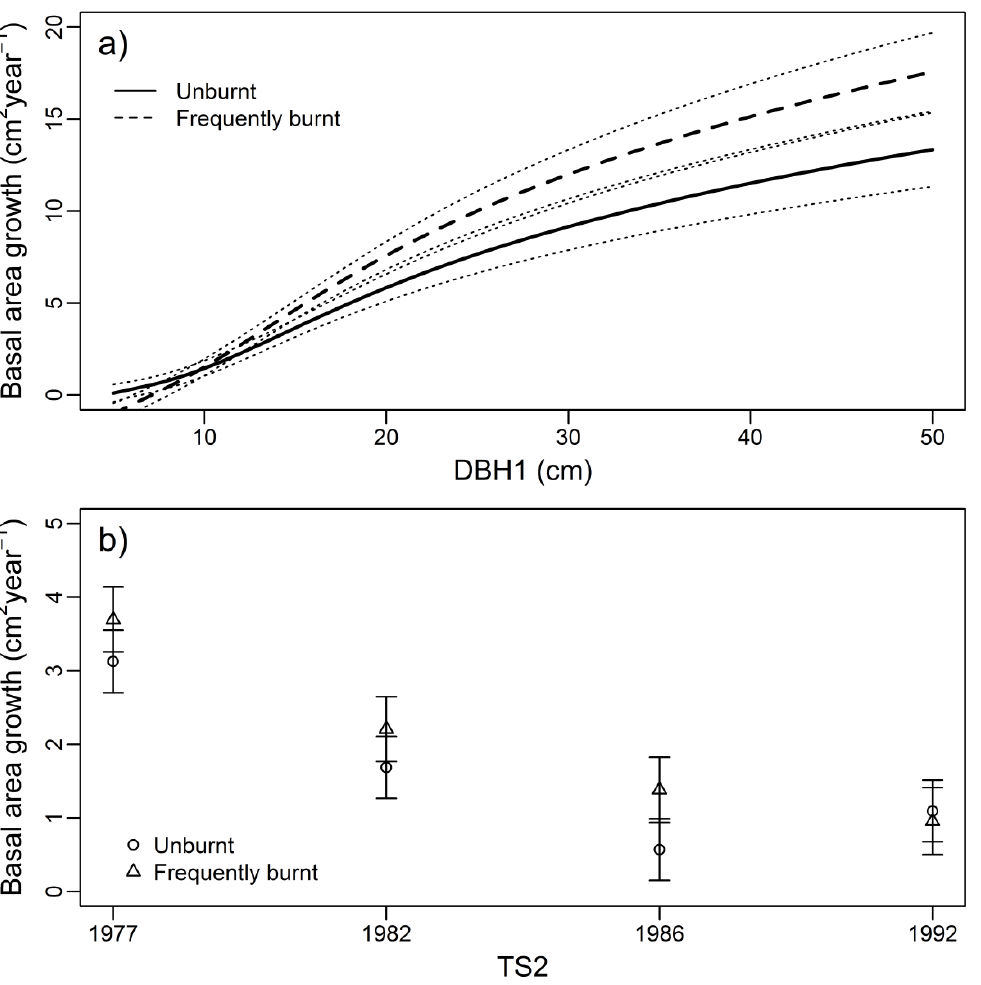
Figure 5. Model predictions of annual change in basal area of understorey species between measurement periods (cm 2 year −1 ) in response to: ( a ) burning treatment and DBH at the first survey (DBH1); and ( b ) timing of the second survey (TS2) and burning treatment. Dotted lines in ( a ) show the 95% confidence interval. Error bars in ( b ) show 95% confidence intervals. Predictions held TS2 constant at 1992 in ( a ) and DBH1 constant at 8 cm in ( b